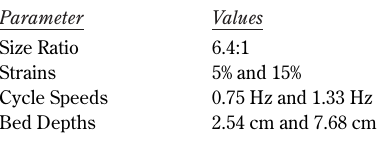
Table 3 Validation schedule for binary mixtures of spherical glass beads